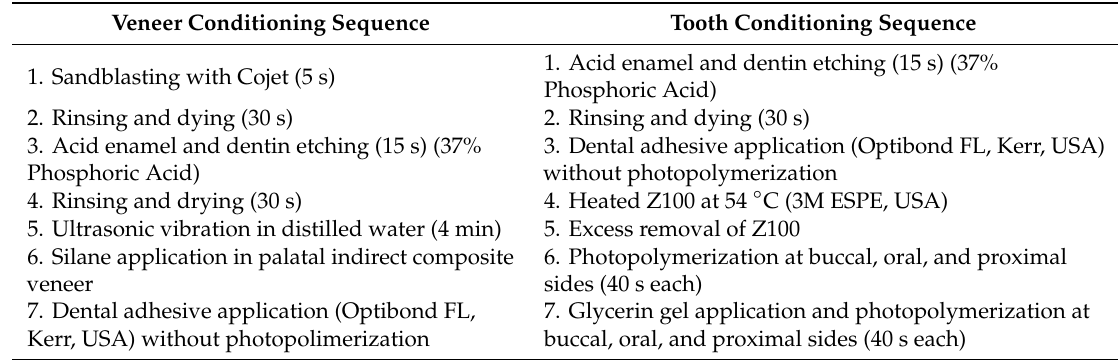
Table 1. Conditioning protocol of the tooth and indirect composite veneer.